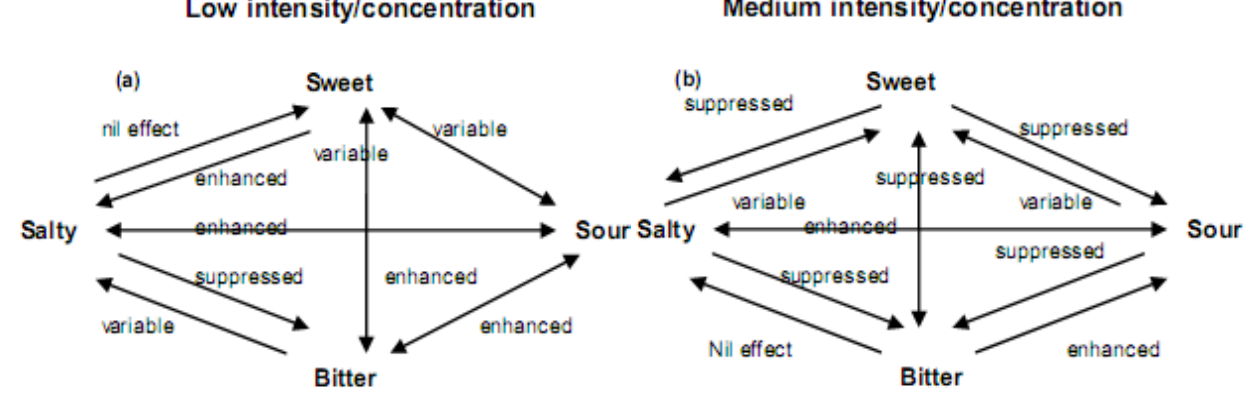
Figure 3. Schematic review of binary interactions of taste qualities at different levels of intensity/concentration, Adapted with permission from Elsevier